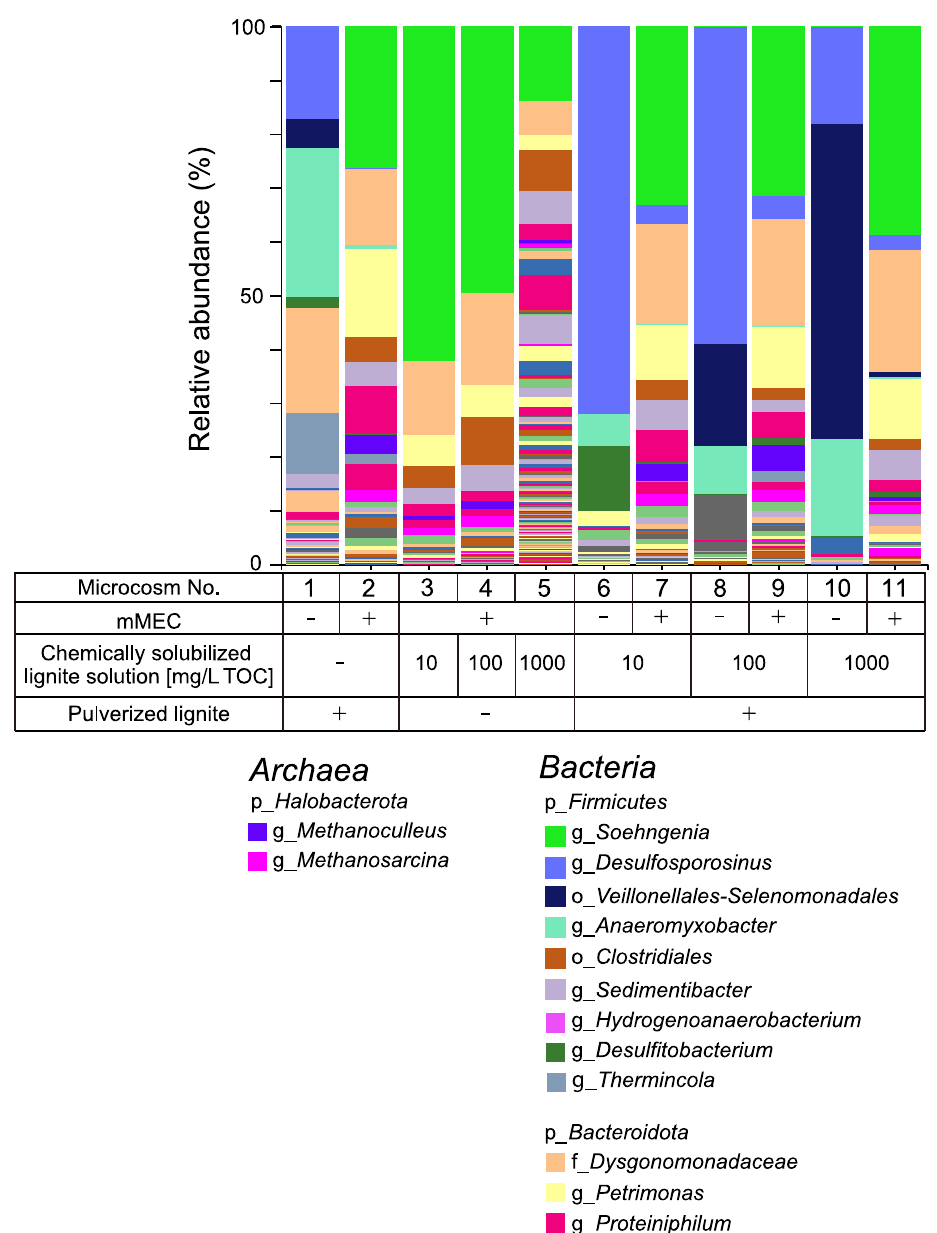
Figure 3. Microbial community structure of each microcosm experiment using mMEC. Major taxo- nomic groups with a relative abundance of >c.a. 1.0% were indicated. p_, Phylum level; o_, Order level; f_, Family level; g_, Genus level. − , not added or absent; +, added or present.